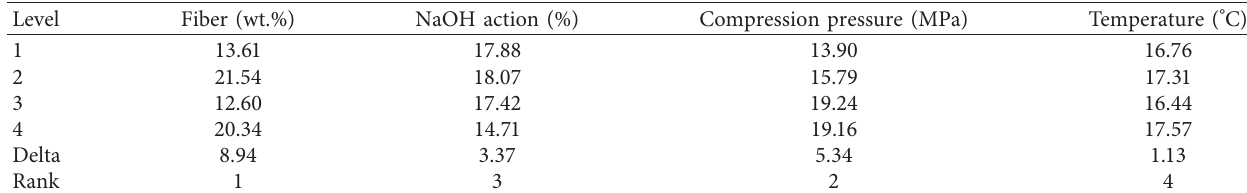
Table 6: Response table for means (impact strength).